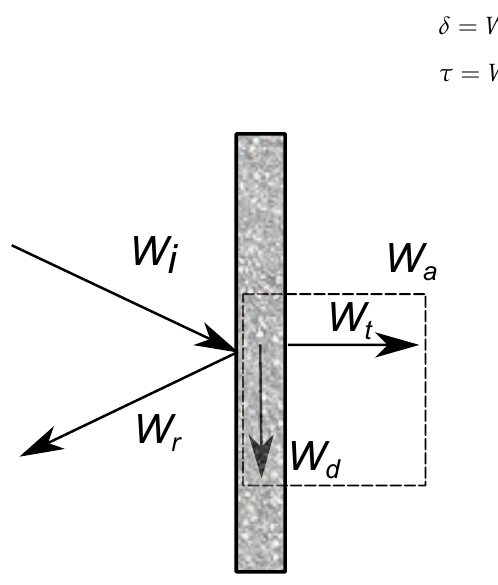
Figure 2. Decomposition of a sound wave W i impinging a wall into its reflected W r , dissipated W d and transmitted W t components. The sum of the dissipated and transmitted components represents the absorbed W a